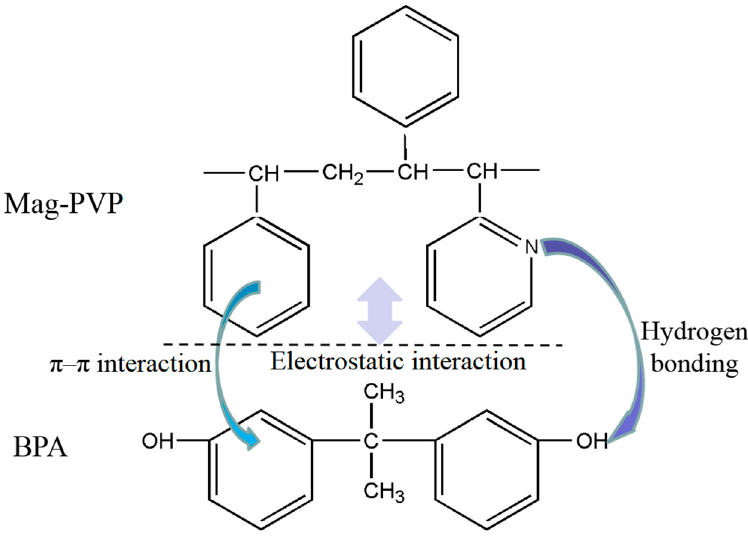
Figure 8. Possible mechanism for BPA adsorption on Mag-PVP.